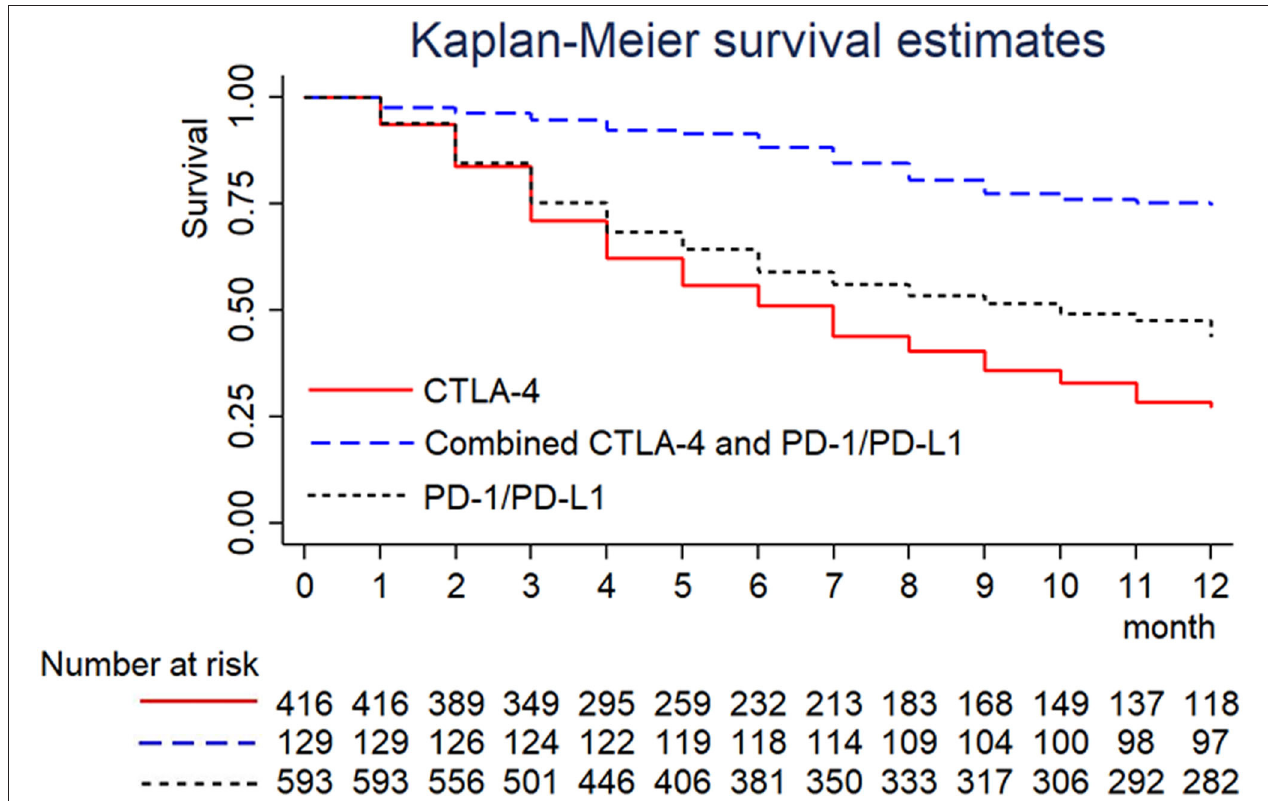
FIGURE 4 | Kaplan–Meier curve of 12-month survival in BM patients treated with ICIs. Kaplan–Meier curve showing pooled 12-month survival in BM patients treated with